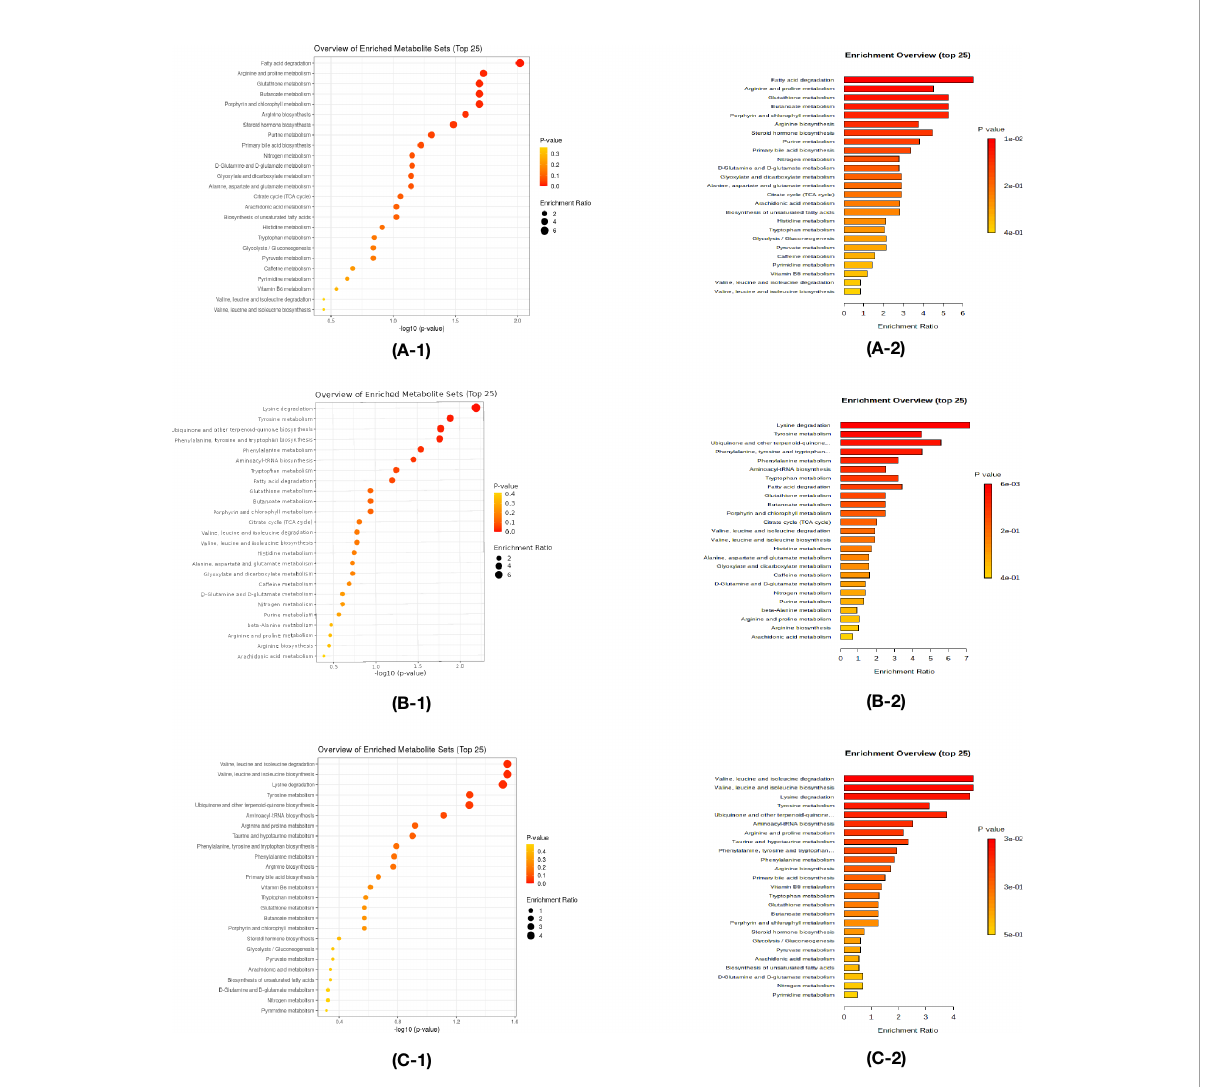
FIGURE 5 Enrichment analysis was performed to con fi rm the signi fi cantly changed metabolic pathway based on the Kyoto Encyclopedia of Genes and Genomes database through Metaboanalyst. (A-1,A-2) The comparison between the control and HT with euthyroidism group. (B-1,B-2) The comparison between the control and HT with subclinical hypothyroidism group. (C-1,C-2) The comparison between the HT with euthyroidism and HT with subclinical hypothyroidism